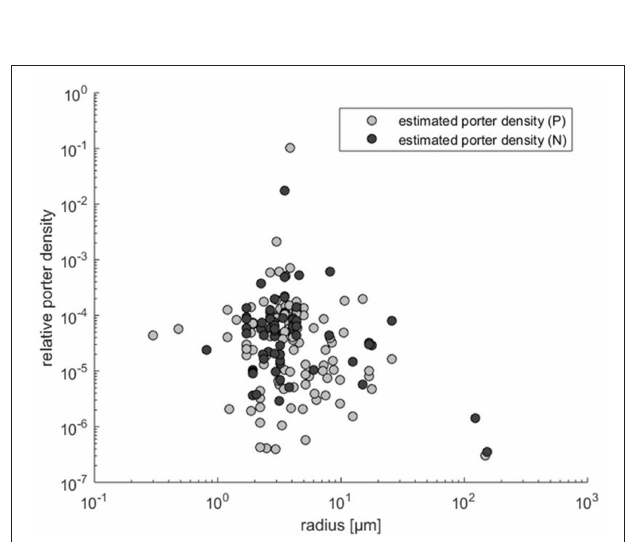
FIGURE 3 | Transporter density estimates (obtained by Equation 3) vs. cell radius calculated from Edwards et al.